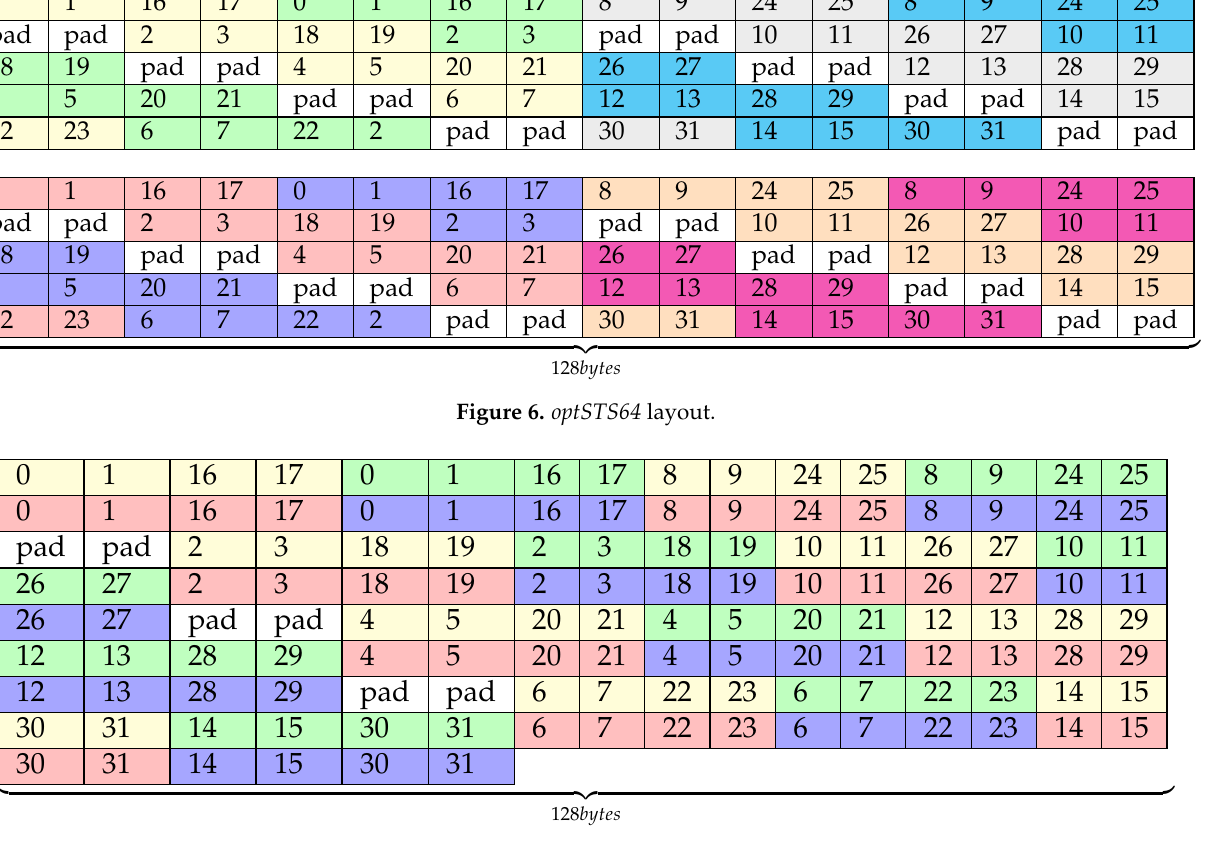
Figure 7. Final optSTS64 layout.